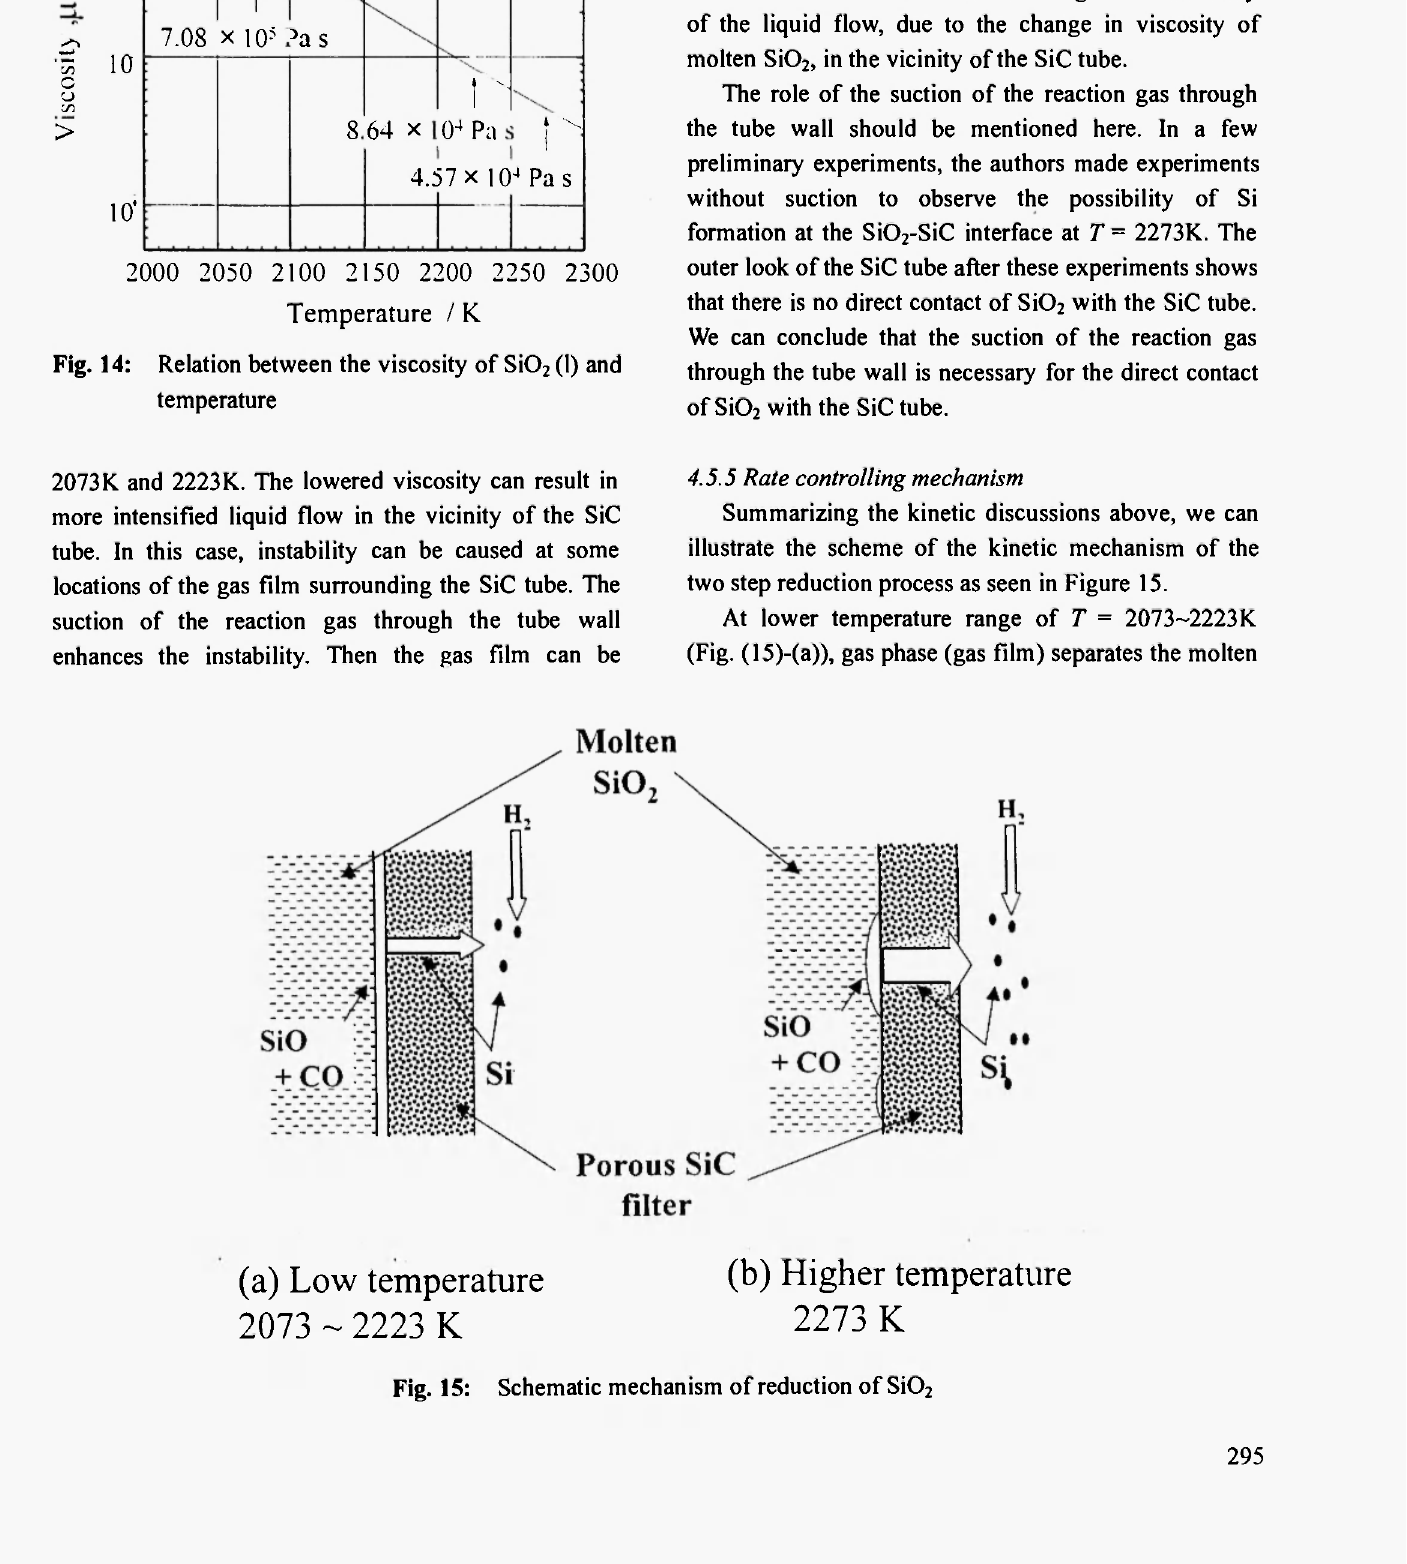
Fig. 14: Relation between the viscosity of Si0 2 (1) and temperature